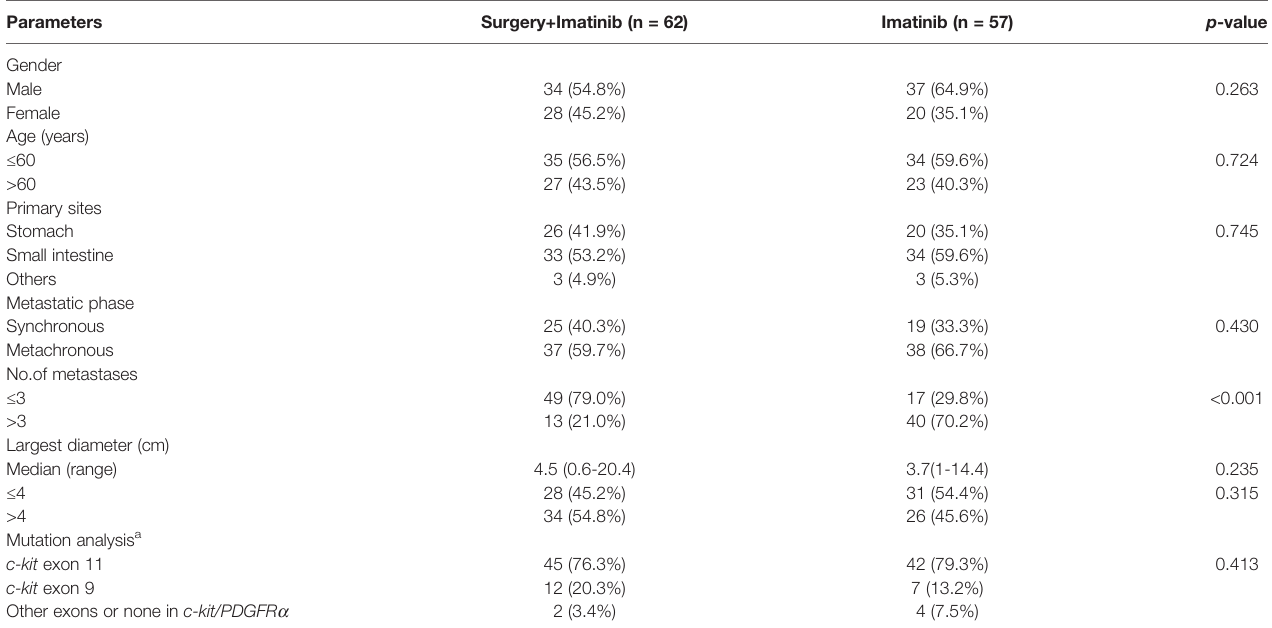
TABLE 1 | Baseline clinical characteristics of all patients.